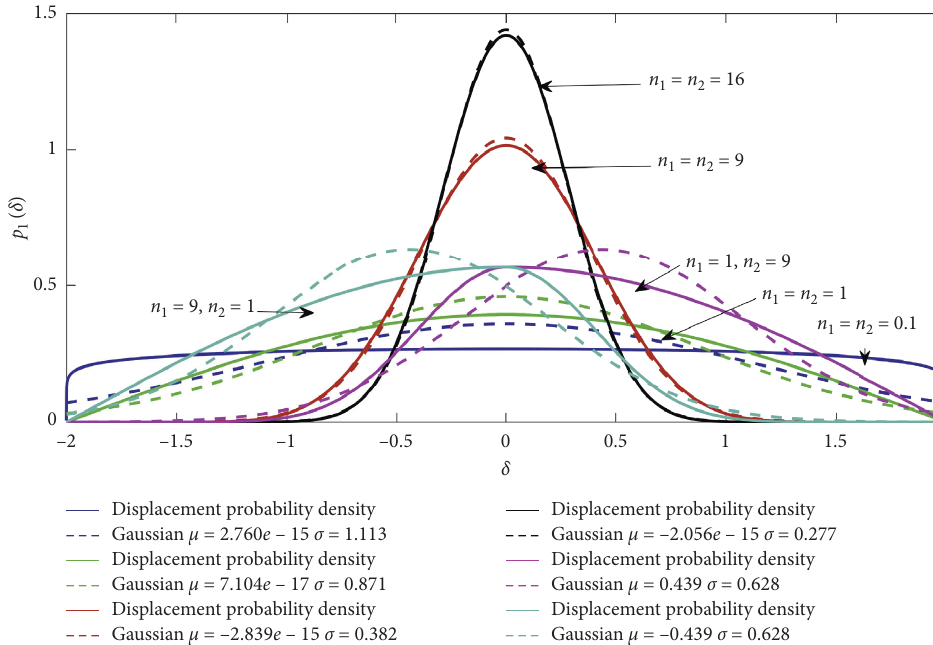
Figure 9: Displacement PDFs of ATNPS for various values of